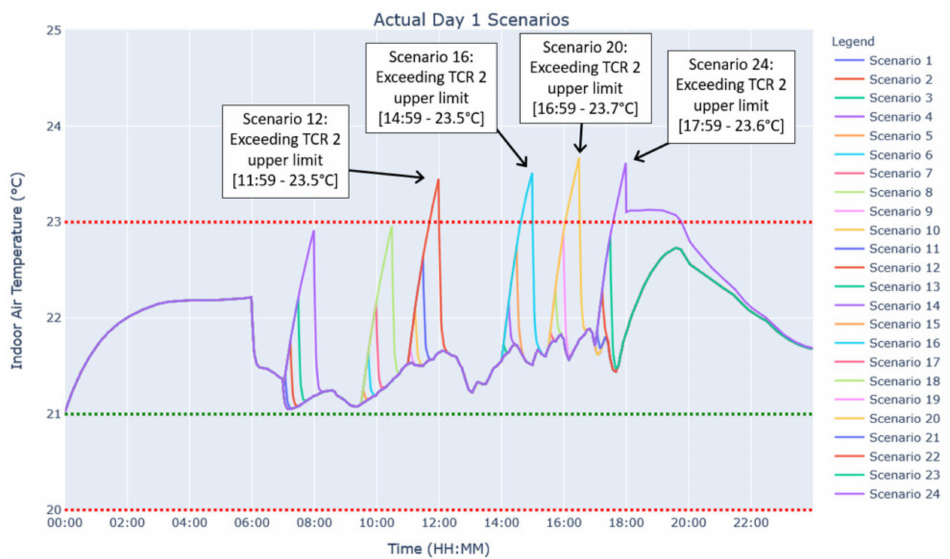
Figure 12. Daily internal air temperature profile for each actual Day 1 scenario under TCR2 conditions (red dashed